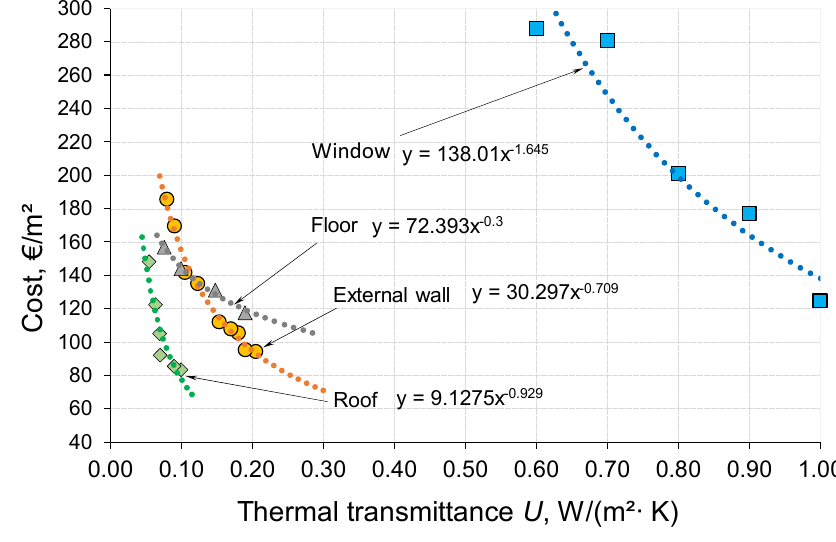
Figure 2. Cost of the building envelope.